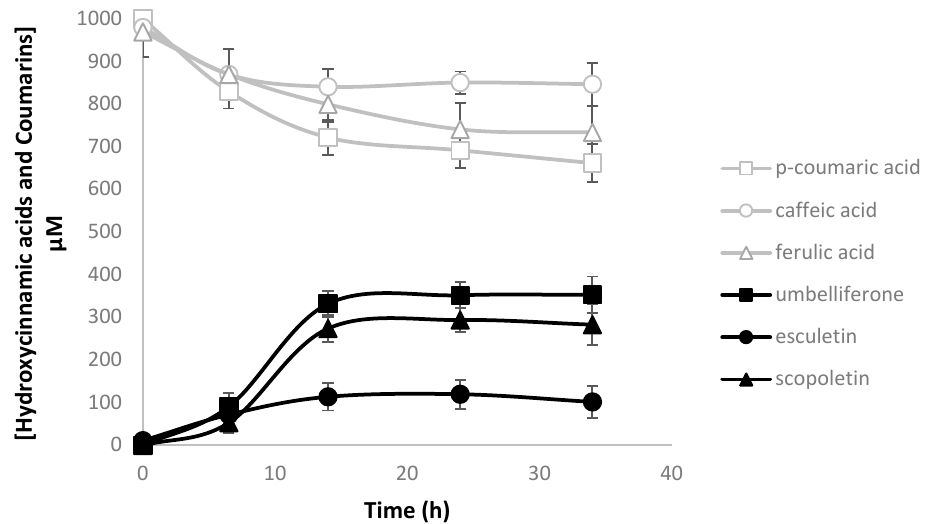
Figure 3. Coumarin production in Escherichia coli using different hydroxycinnamic acids as precursors. Umbelliferone, esculetin, and scopoletin are catalyzed from p -coumaric acid, caffeic acid and ferulic acid when pAC-4CL1 and pET28GST-C2 ′ H are expressed. 4CL1: 4-coumarate-CoA ligase 1; C2 ′ H: p -coumaroyl-CoA 2 ′ -hydroxylase.